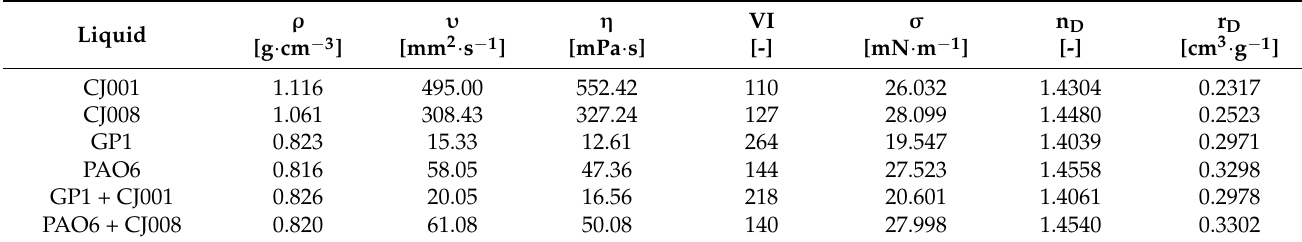
Table 1. The basic properties of mixtures and their components determined at the temperature of 25 ◦ C.